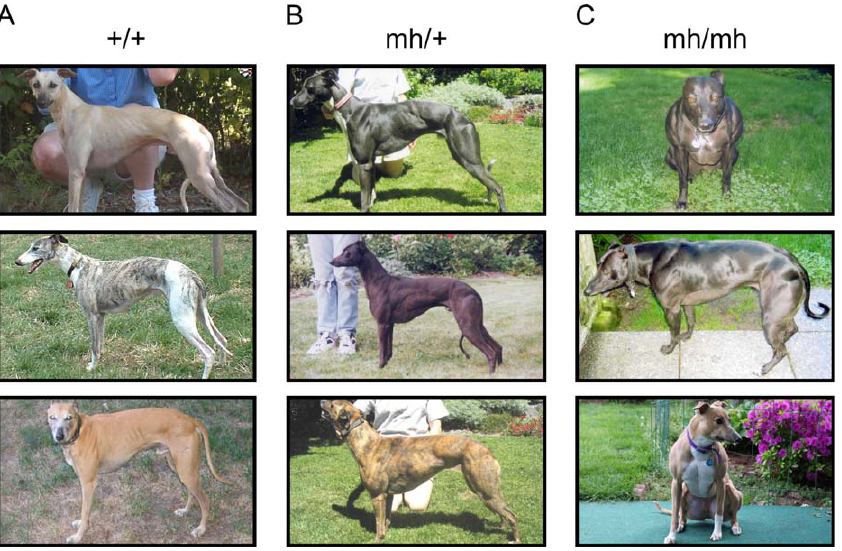
Figure 1. Comparison of Whippets with Each of the Three Potential Genotypes (A) Dogs have two copies of the wild-type allele ( þ / þ ). (B) Dogs are heterozygous with one wild-type allele and one mutant cys ! stop allele ( mh/ þ ) . (C) Dogs are homozygous for the mutant allele with two copies of the cys ! stop mutation (mh/mh). All photos represent unique individuals except for the top and middle panels in the righthand